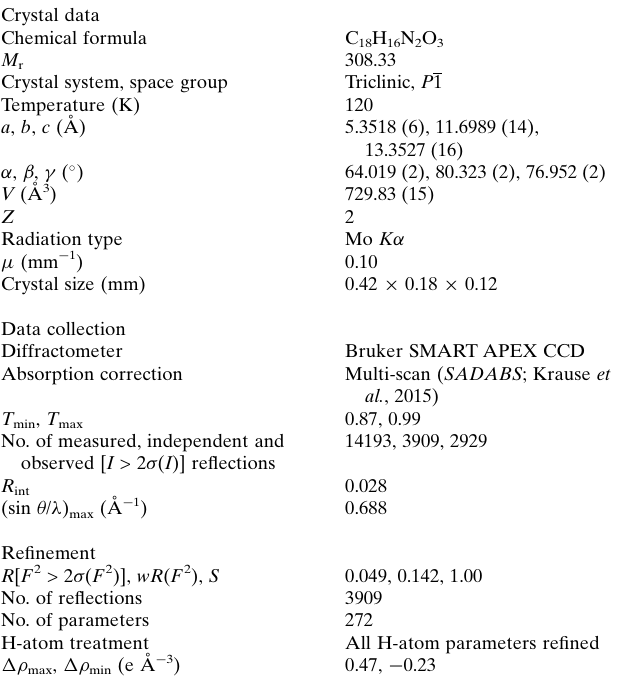
Table 2 Experimental details. Crystal data Chemical